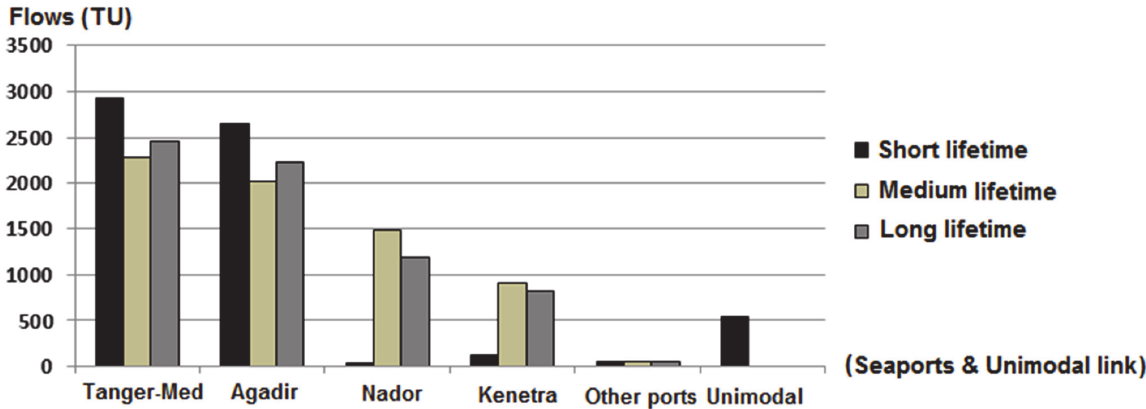
Fig. 7. Percentage of goods transported through seaports of the origin